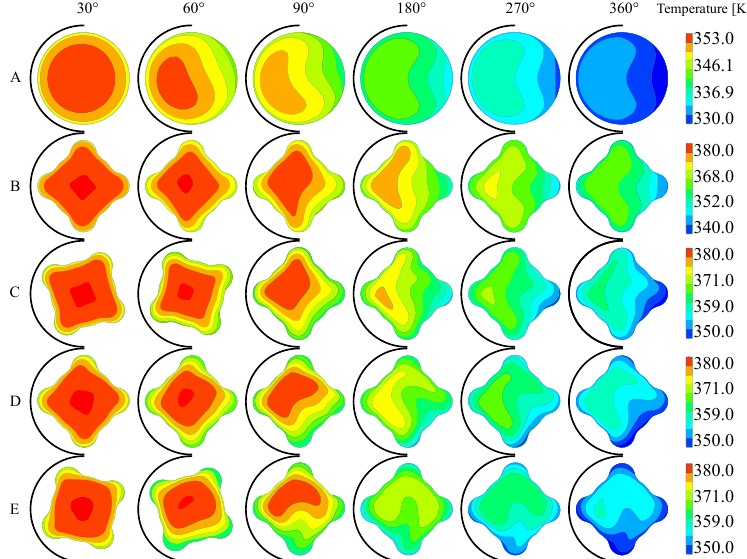
Figure 8. Temperature contours for the inner tube with Dean number 1000 for inner tube and with Dean number 4411 for outer tube. A: tube-in-tube. B: four ridges without twist. C: four ridges with 1 twist. D: four ridges with 3 twist. E: four ridges with 5 twist.